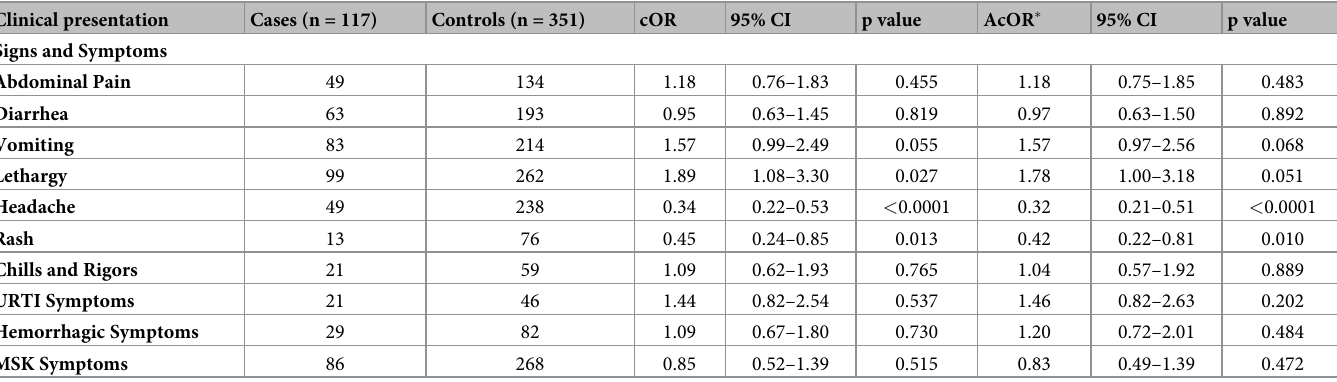
Results comparing laboratory parameters between the cases and controls are displayed in Table 4. On admission, patients with severe dengue have significant derangements in various hematological and biochemical laboratory parameters. Hematological investigations showed that patients with severe dengue have significantly higher white cell counts (median 5.00; IQR: